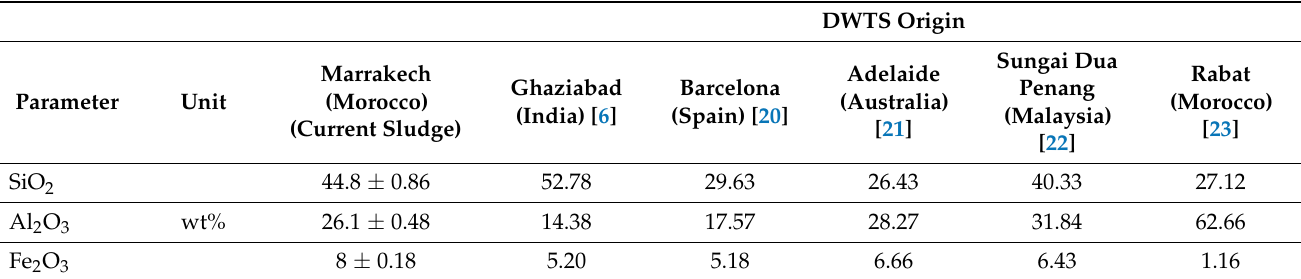
Table 2. Major Chemical composition of DWTS from different